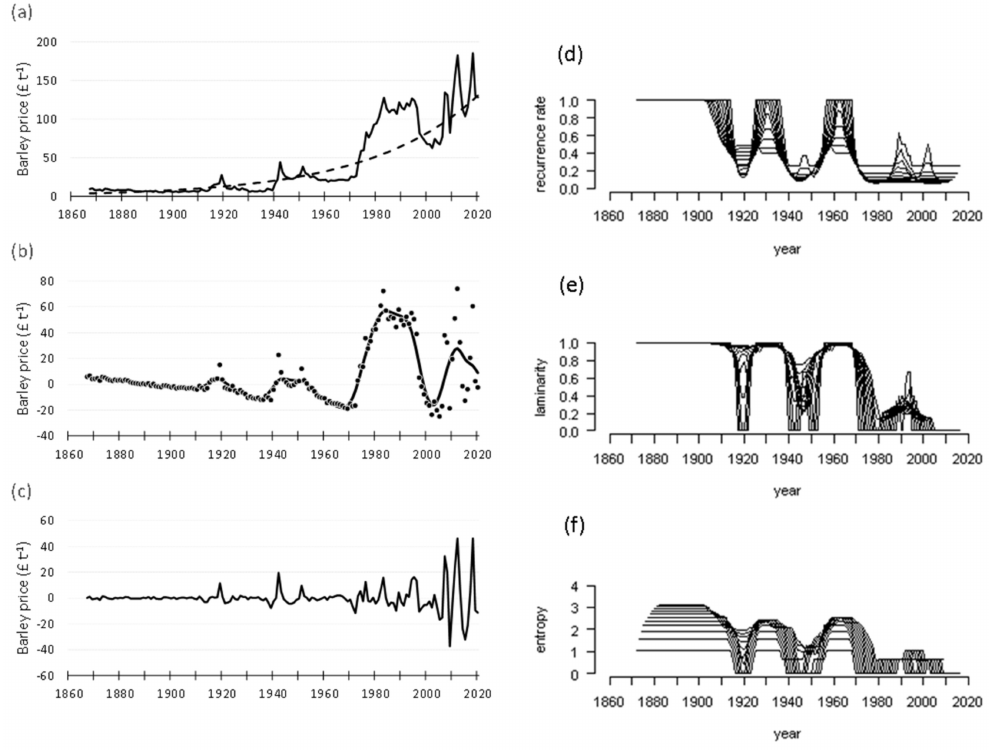
Figure 4. Time series analysis results and RQA results for barley price in Scotland (1867–2020): ( a ) data and long-term trend, ( b ) deviation from long-term trend and smoothing spline, ( c ) residuals from long- and medium-term trends, ( d ) recurrence rate, ( e ) laminarity, and ( f ) entropy from RQA using sliding windows of 10–30 years duration in 2-year